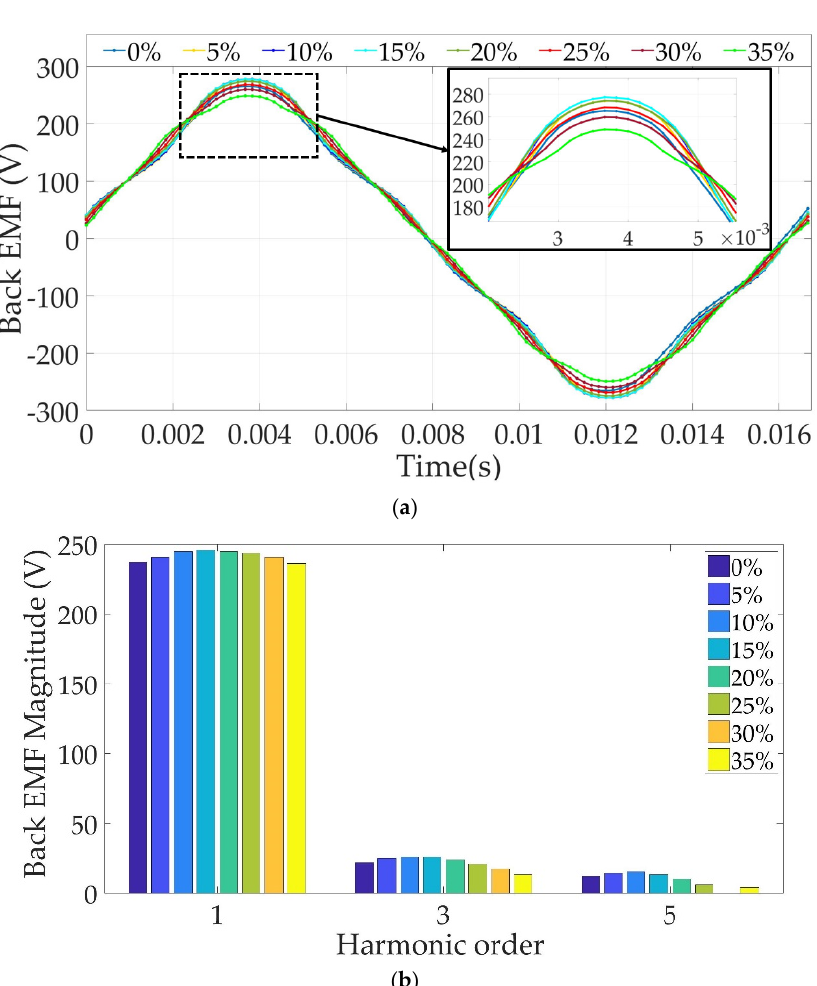
Figure 12. ( a ) Back-EMF curve at different ratios α ( β = 50%). ( b ) Back-EMF magnitude of harmonic order at different ratios α ( β = 50%).